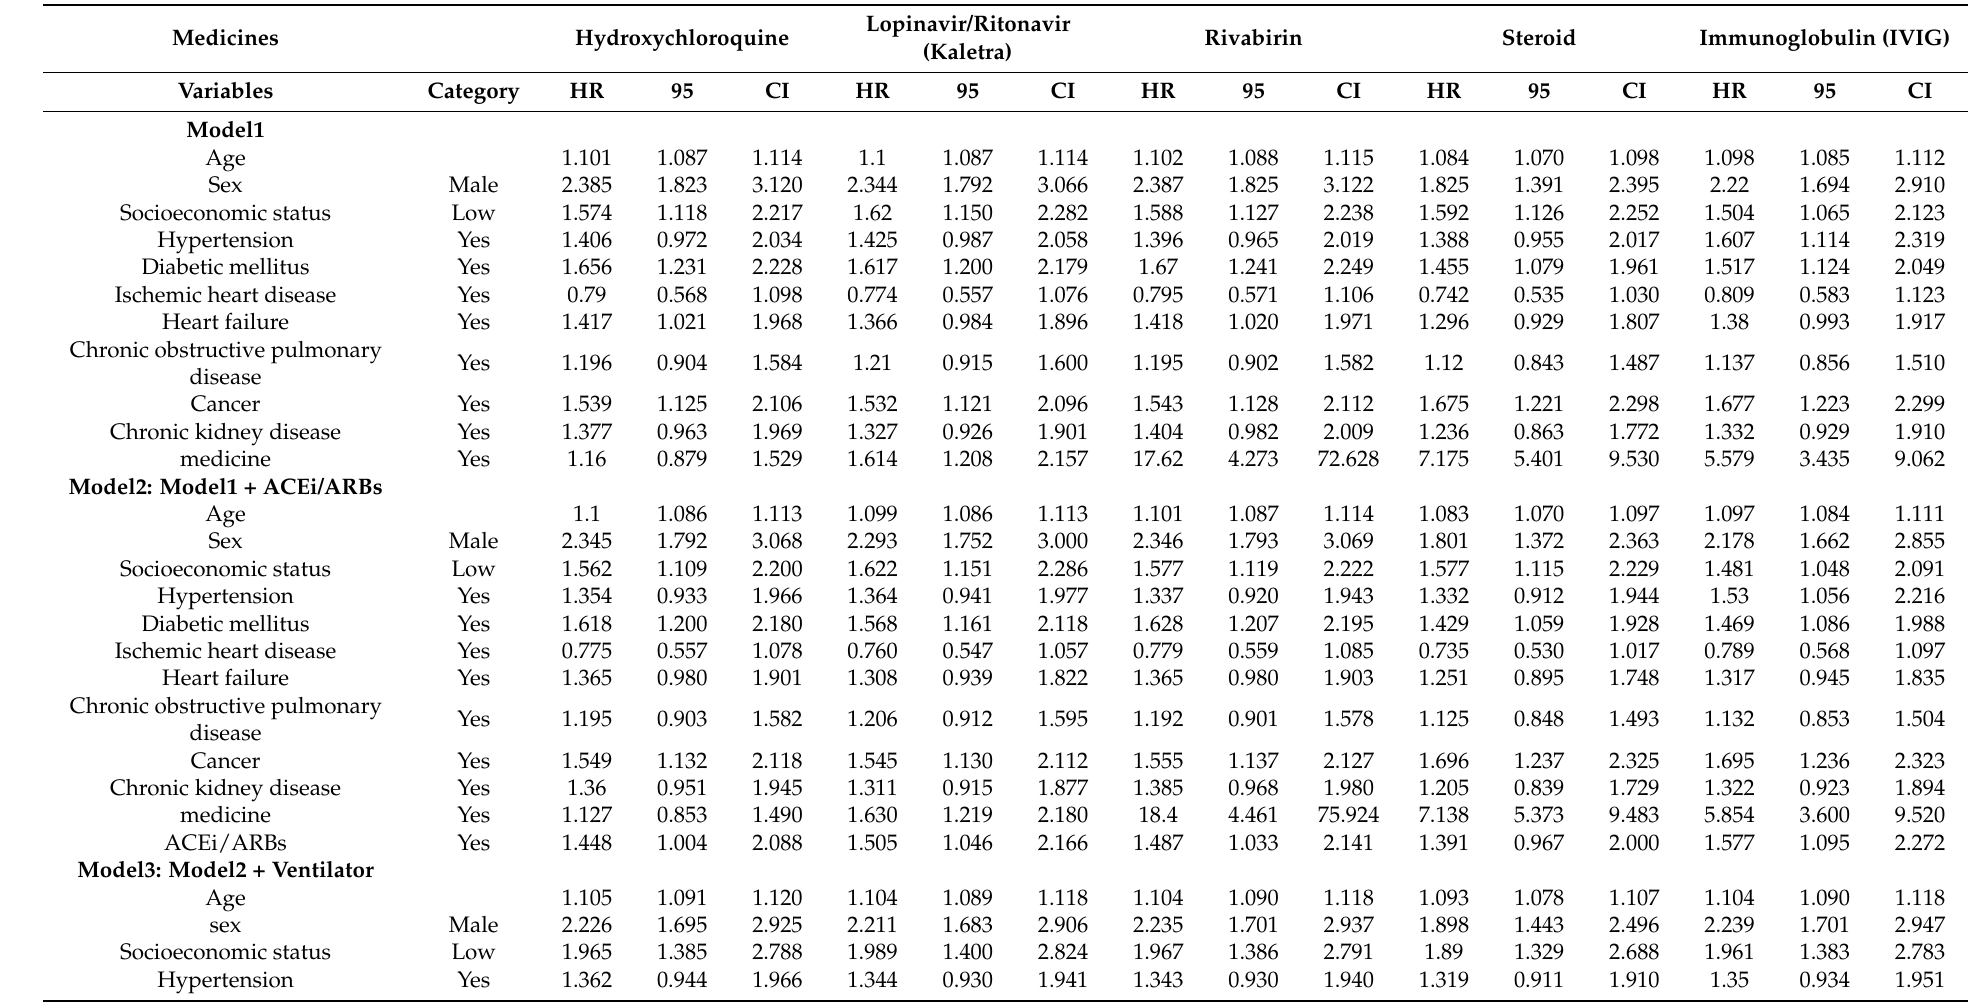
Table 2. Effect of treatments on mortality for